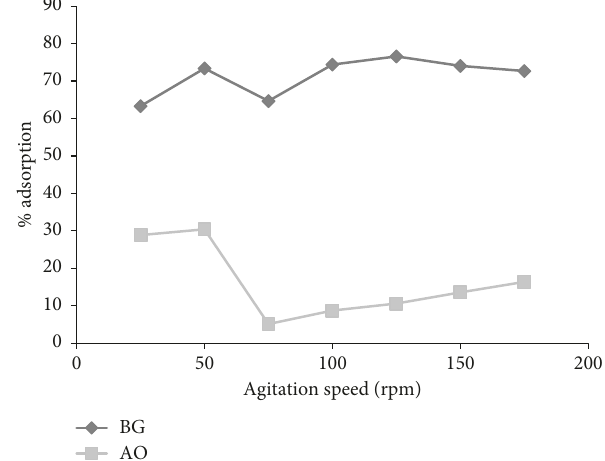
Figure 7: Graphical illustration of agitation speed effect on BG and AO-74 dye elimination by PR leaves.